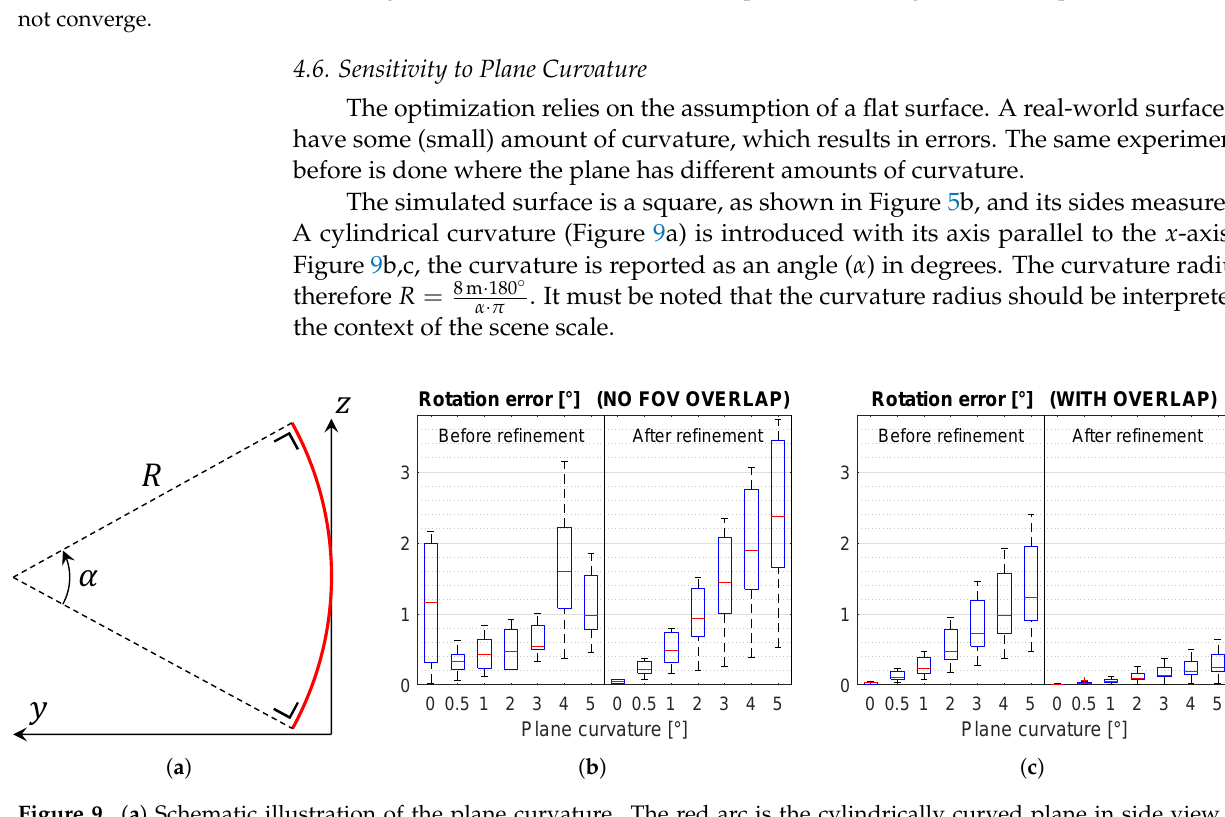
Figure 9. ( a ) Schematic illustration of the plane curvature. The red arc is the cylindrically curved plane in side view. ( b ) Results when varying the plane curvature for the scene with no overlap and ( c ) for the scene with